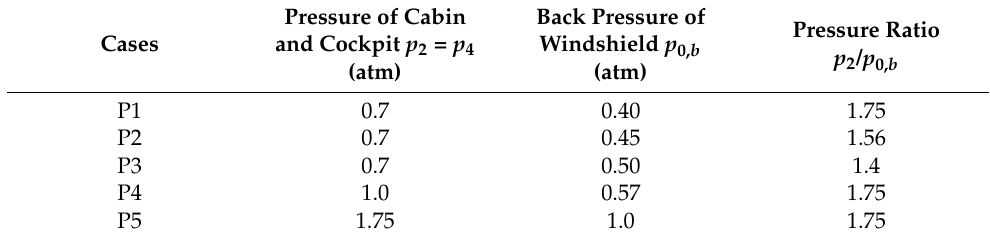
Table 5. Varying pressure cases.